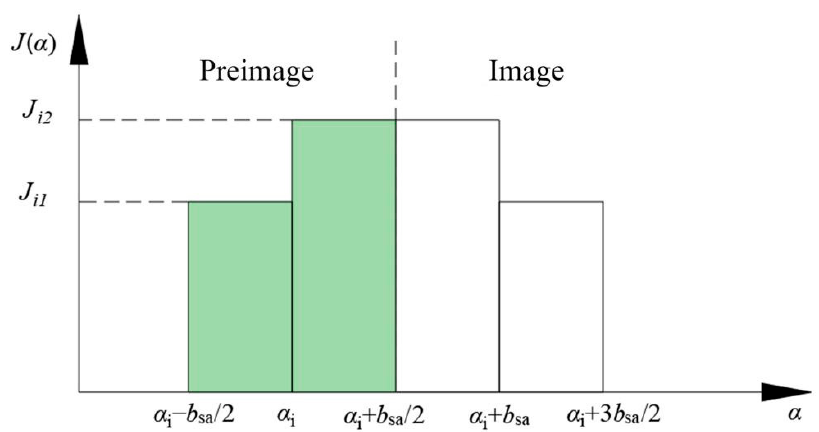
Figure 4. Current density distribution in the stator slot after mirroring.